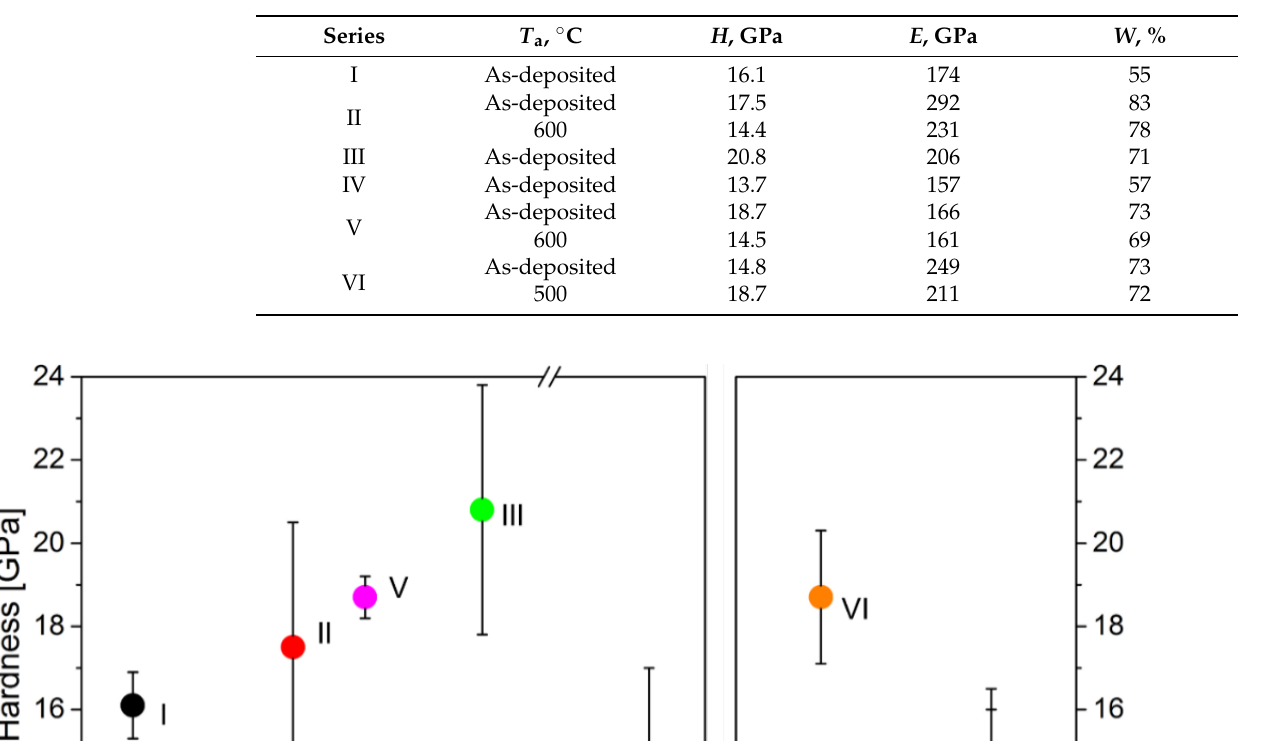
Table 2. Mechanical properties of the films.